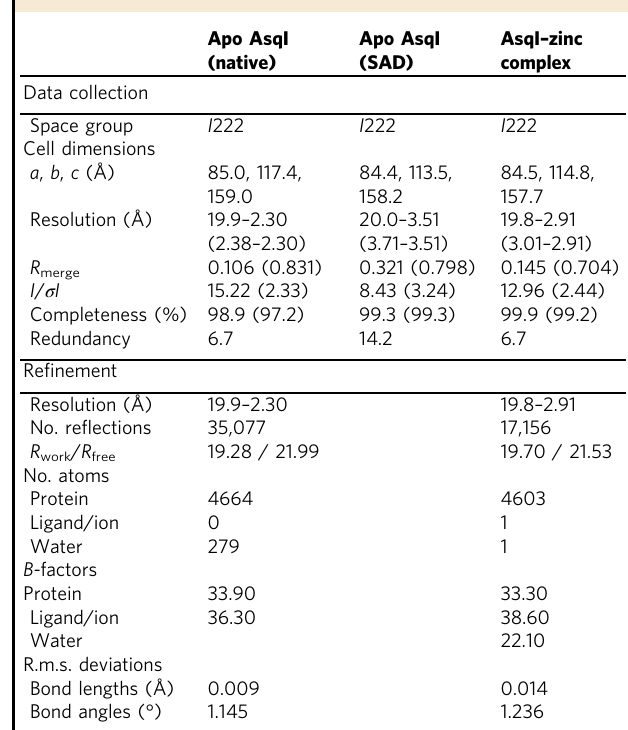
Table 1 Data collection and re fi nement